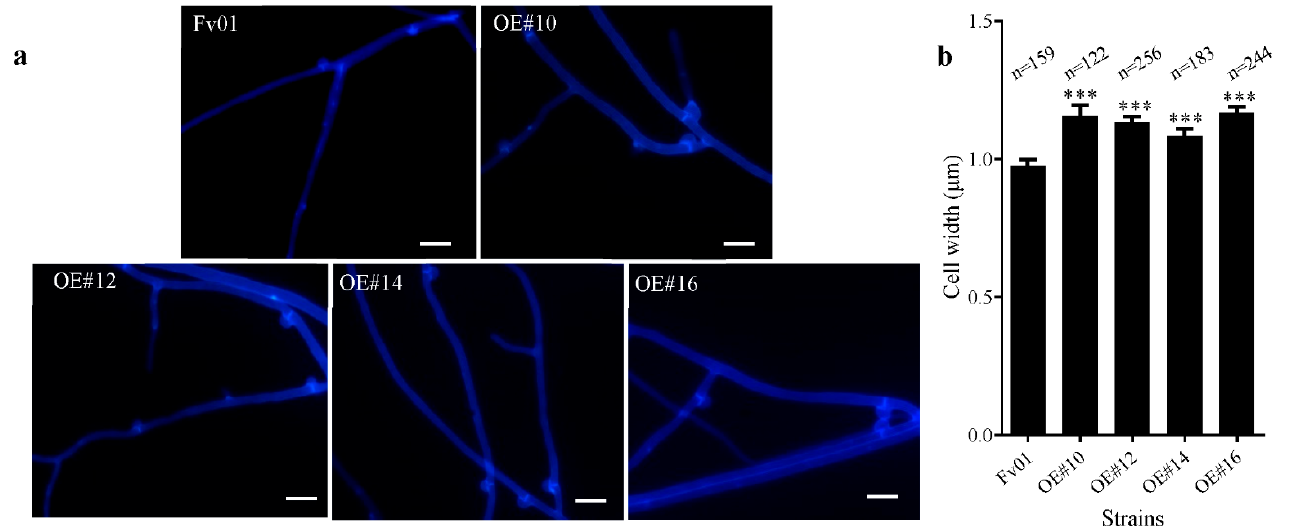
Figure 3. Microscopic observation of morphology and measurement of the cell width of F. filiformis FfGS6 overexpression transformants. ( a ) Fluorescence microscopic observation of mycelium (scale bar = 5 μ m). ( b ) Measurement of cell width at the clamp connection. Asterisks represent significant differences versus Fv01 ( t -test, n ≥ 110; ***, p < 0.001).